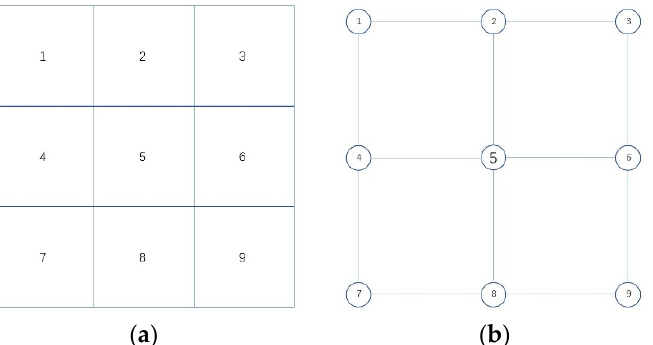
Figure 5. Control network. ( a ) Control sector. ( b ) Control nodes and edges. In Figure ( a ), we draw out 9 square sectors, where the numbers 1–9 indicate the designations of the 9 control sectors.In Figure ( b ), the numbers 1–9 indicate the nodes corresponding to the controllers of the 9 sectors, and the connecting lines between the numbers indicate the presence of connected edges.